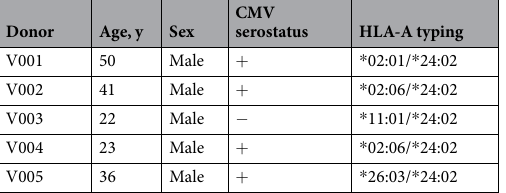
Table 1. All donors were screened for CMV serostatus and typed for HLA class I and II alleles. Three donors were HLA-A